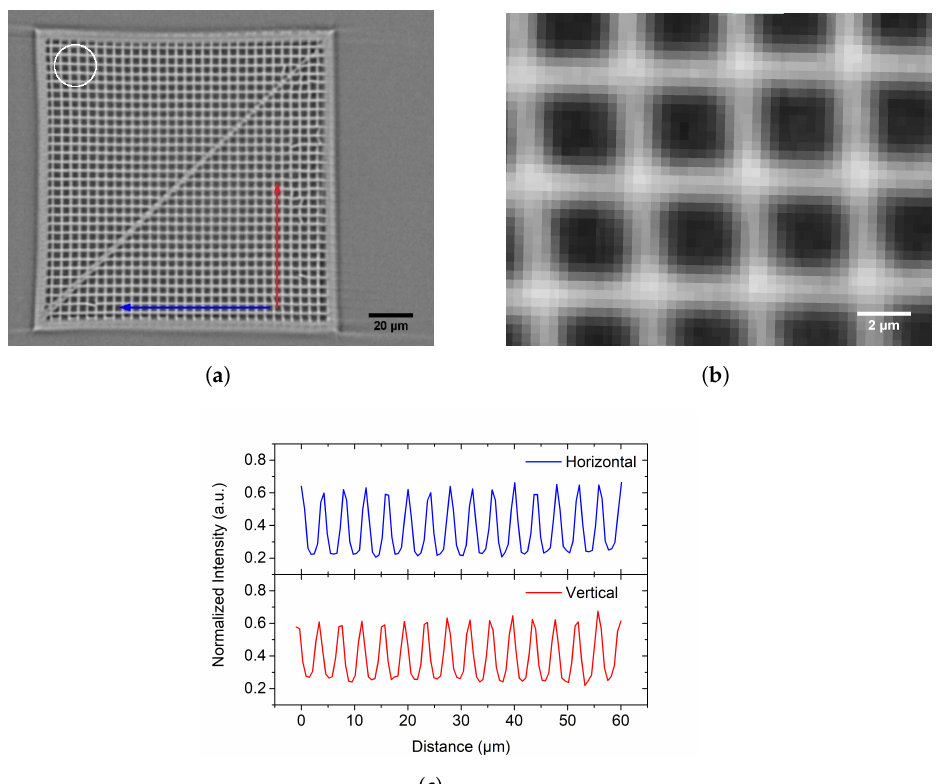
Figure 9. ( a ) Horizontal slice through the structure, the blue and red arrows mark a line measurement; ( b ) Zoom-in of high-resolution image area corresponding to the white circle in ( a ). Square-like areas of the same gray value correspond to a cut of a voxel with a nominal size of 0.33 × 0.33 × 0.33 µm 3 . (Voxels appear in a non-regular grid, as the original voxel grid of the scan and virtual grid of the scanned object do not match. The sample was slightly tilted during the scan. However, the image was aligned to the object’s grid, therefore, the voxel grid appears to be tilted in the print-out); ( c ) Normalised intensity along the blue and red arrow shows clear detectability of multiple single voxel